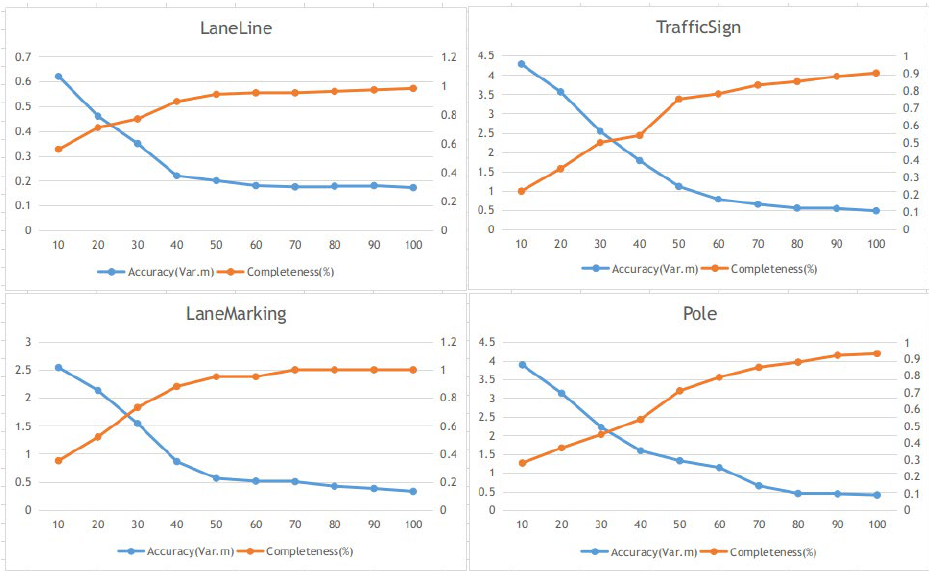
Figure 9. The influence of different observation times on the accuracy and completeness of fusion mapping, the horizontal axis represents the observation times (aggregation times), the left vertical axis represents the relative precision (unit: m), and the right vertical axis represents the semantic element completion